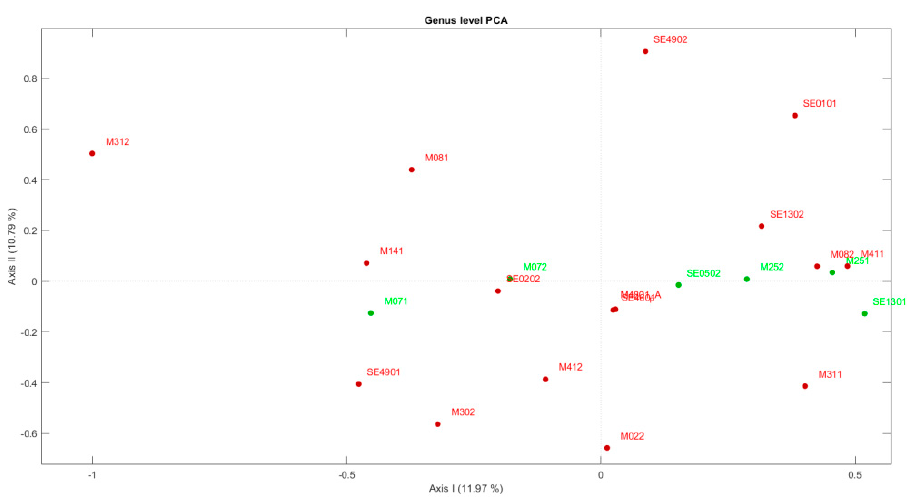
Figure 12. The results of PCA at the genus level. Green: OSA − atherosclerosis. Red: OSA + atherosclerosis. No visible clustering was seen in PCA space. No descriptor variables (bacterial groups) were observed with outstanding importance.